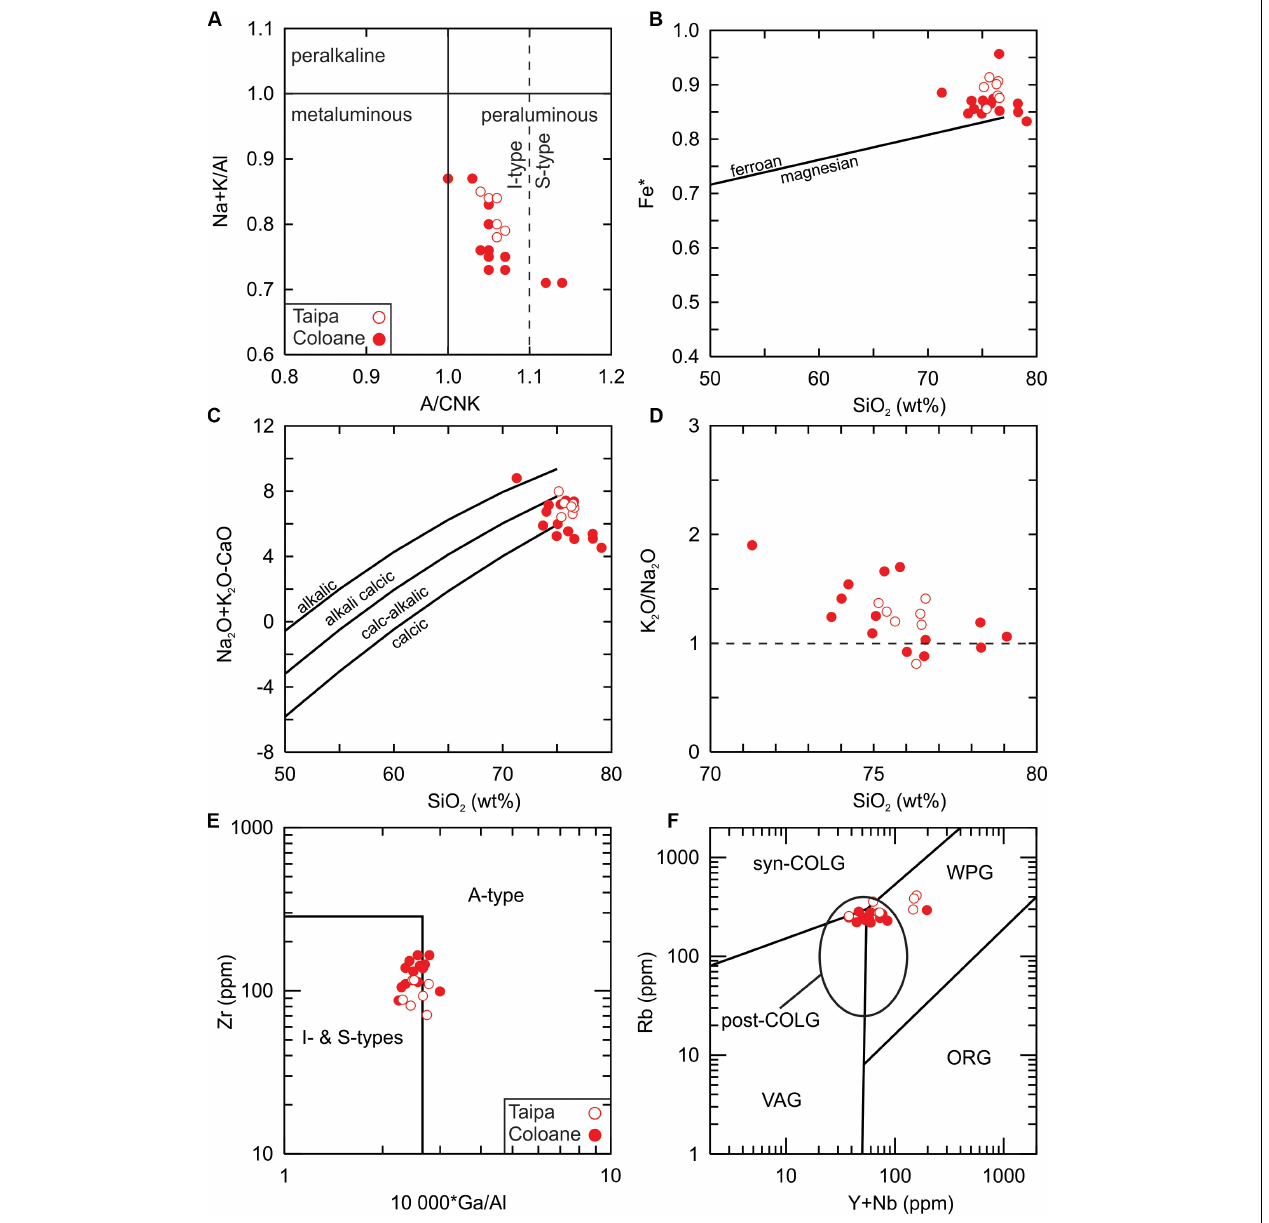
FIGURE 4 | Major element classification plots of the leucogranites from Taipa and Coloane. (A) Alkali index (Na + K/Al) vs. aluminum saturation index (ASI = Al/Ca + Na + K). Classification of the granites according to scheme of Frost et al. (2001) using (B) the Fe* [FeOt/(FeOt + MgO)] value and (C) the modified alkali-lime index (Na 2 O + K 2 O-CaO) vs. SiO 2 (wt%). (D) K 2 O/Na 2 O vs. SiO 2 showing the potassic nature of the rocks. (E) Tectonomagmatic discrimination of granitic rocks using the criteria of Whalen et al. (1987). (F) Classification of granitic rocks using Rb (ppm) vs. Y + Nb (ppm) of Pearce (1996). Syn-COLG, syn-collisional granite; WPG, within-plate granite; VAG, volcanic-arc granite; ORG, ocean-ridge granite; post-COLG, post-collisional granite.